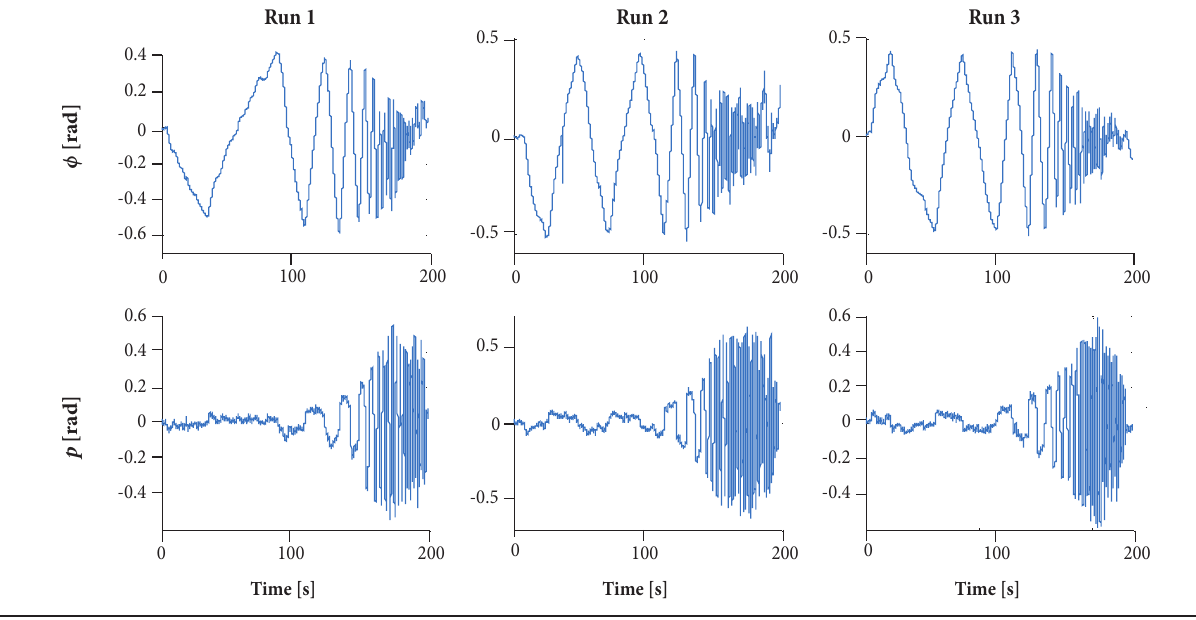
Figure 6. Lateral cyclic control input response — level flight (80